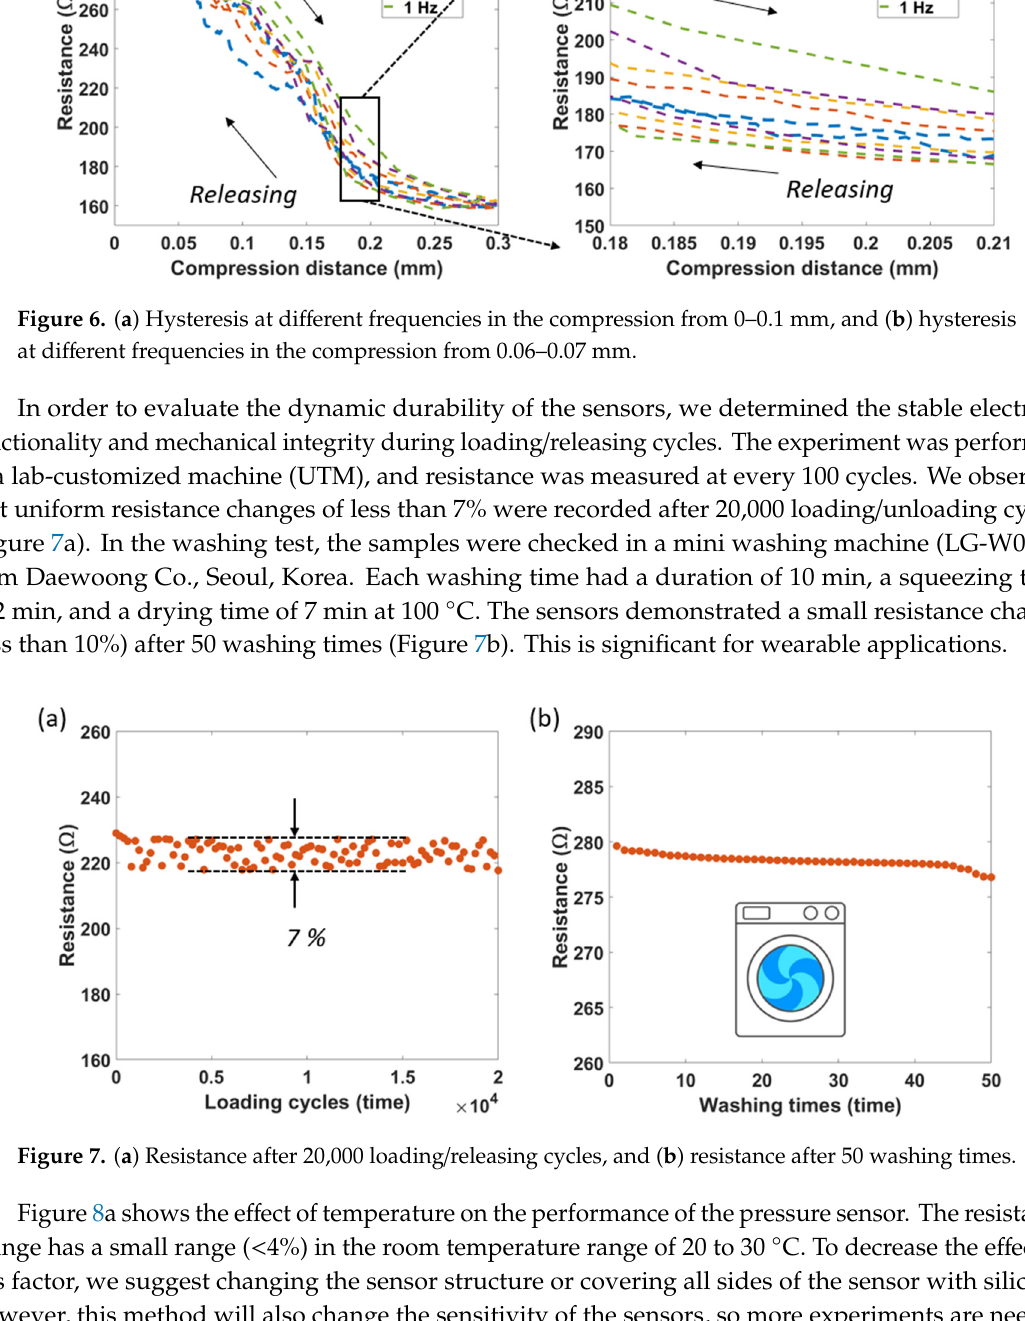
Figure 7. ( a ) Resistance after 20,000 loading/releasing cycles, and ( b ) resistance after 50 washing times